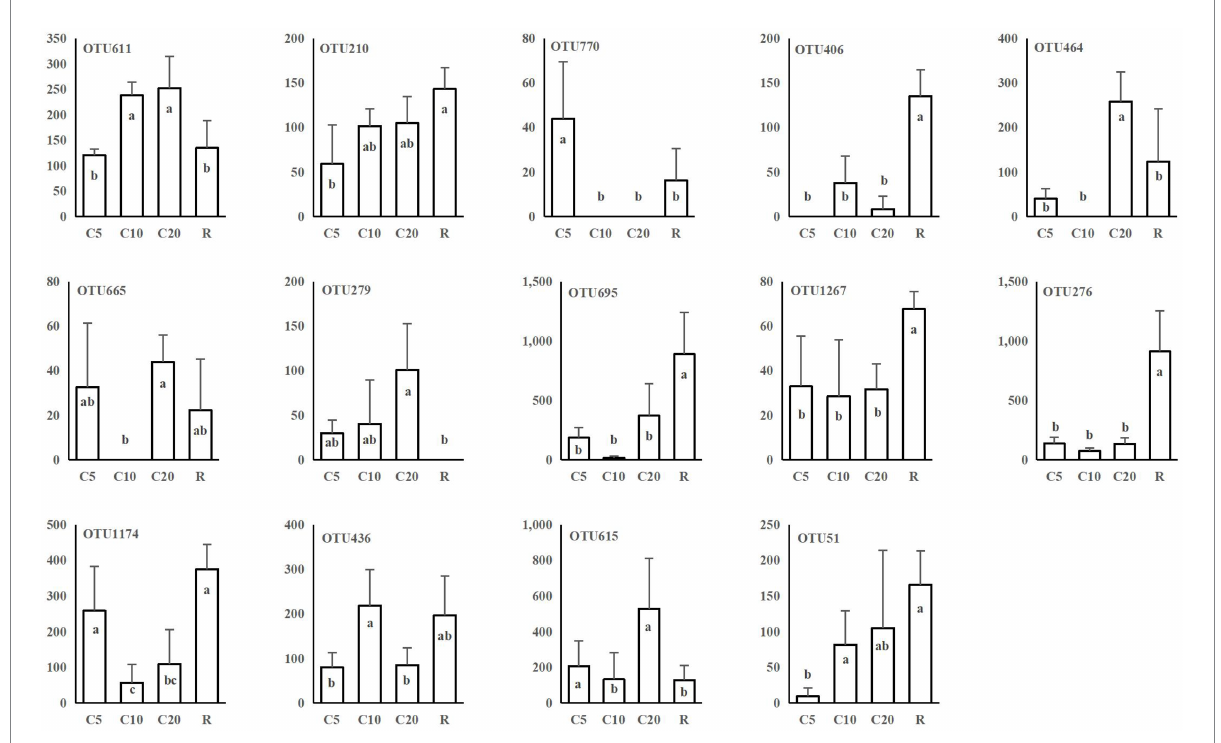
FIGURE 4 Plant-related OTUs with significant differences among the different cropping treatments. The vertical coordinate is the number of sequences in OTUs. Analysis of variance (Duncan’s multiple comparison test) was used to test the significance of differences. The different lowercase letters represent significant differences ( p < 0.05). C5, C10, and C20 represent soybean continuous cropping treatments for 5, 10, and 20 years, respectively, and R represents soybean-corn rotational cropping